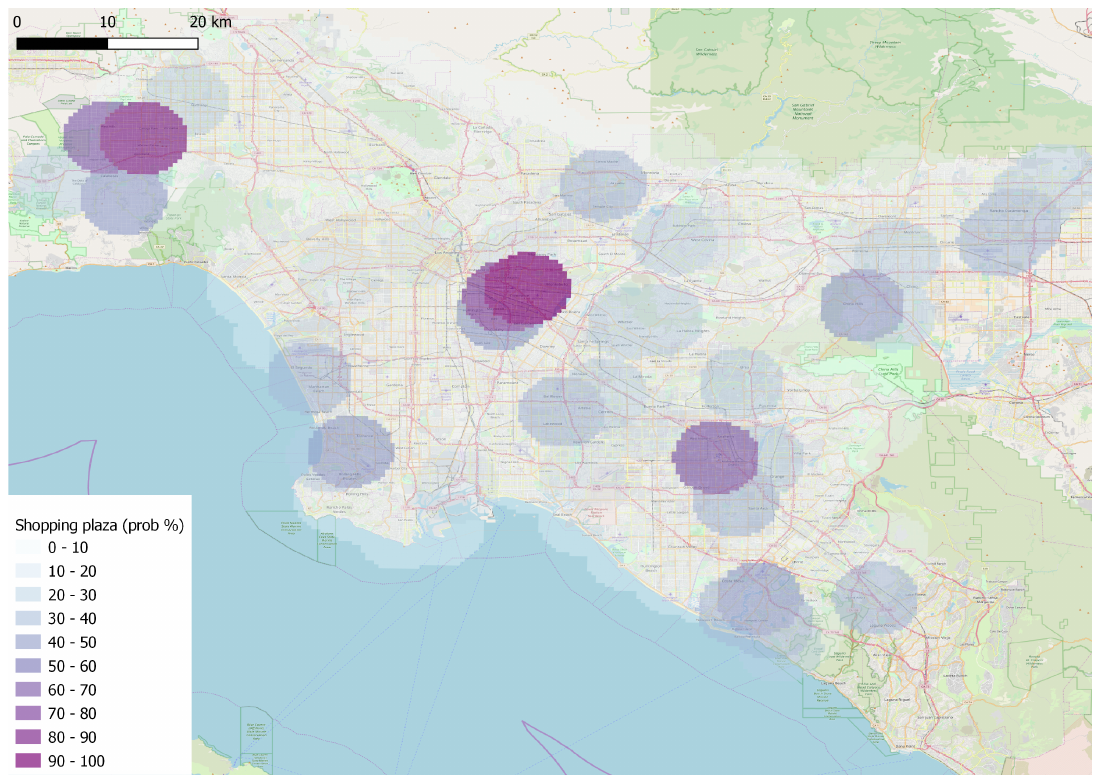
Figure 4. Shopping plazas with significant agreement between the two